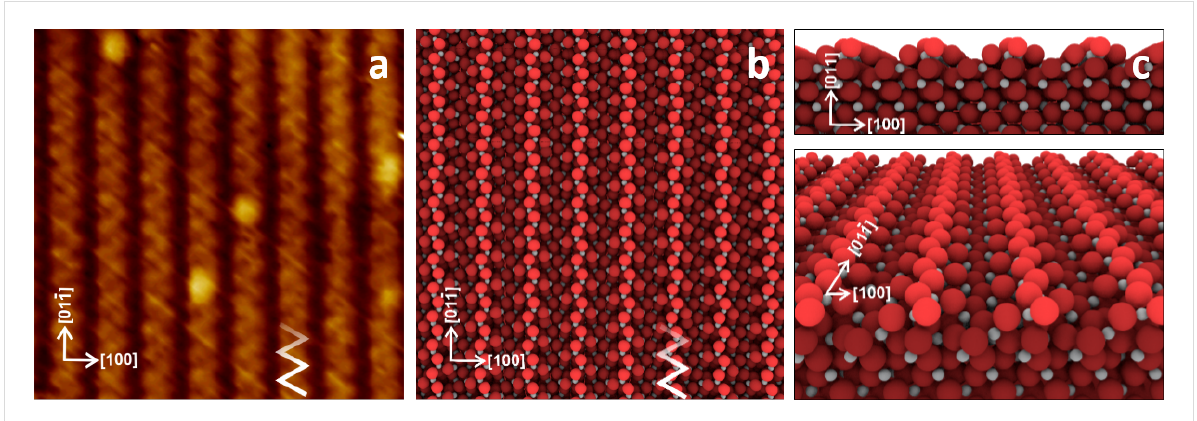
Figure 7: TiO 2 (011)-(2×1) reconstructed surface. (a) 9 × 9 nm empty state STM image; scanning parameters: I = 10 pA, U = 2 V. The white zig-zag pattern indicates the location of the protruding oxygen atoms forming the reconstruction row. The bright dots represent the surface hydroxy groups. (b) Top, (c) cross-section and perspective views of the surface layer “ball model” following the interpretation of the STM image proposed by Woolcot et al. [32]. Light red, red, and dark red circles indicate O; gray small dots indicate Ti